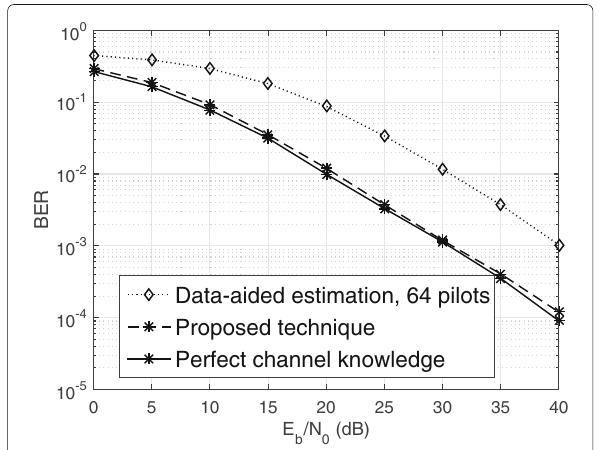
Fig. 6 BER performance of the proposed technique Fig. 7 Effect of SI power level on the BER performance of the proposed technique